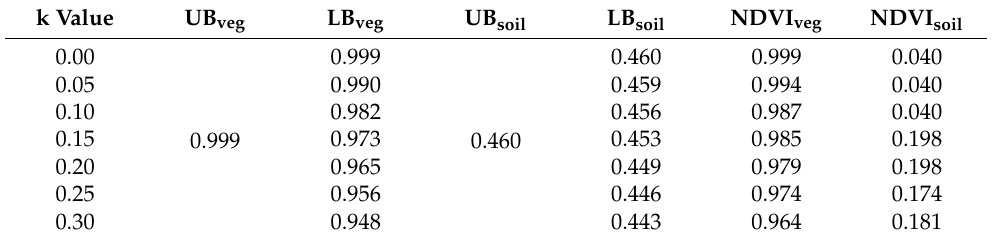
Table 2. Details of parameter values corresponding to different k values.